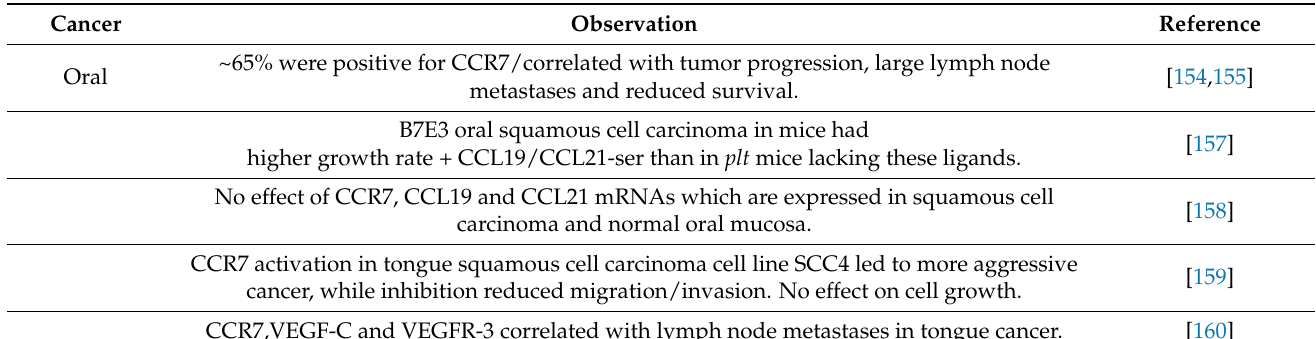
Table 4. CCR7 in Head and Neck and Endocrine cancers. Cancer Observation Reference